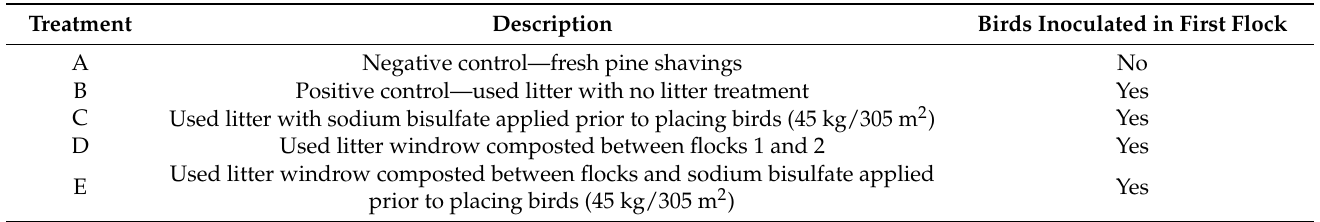
Table 2. Litter treatments applied to used litter before placing second flock.